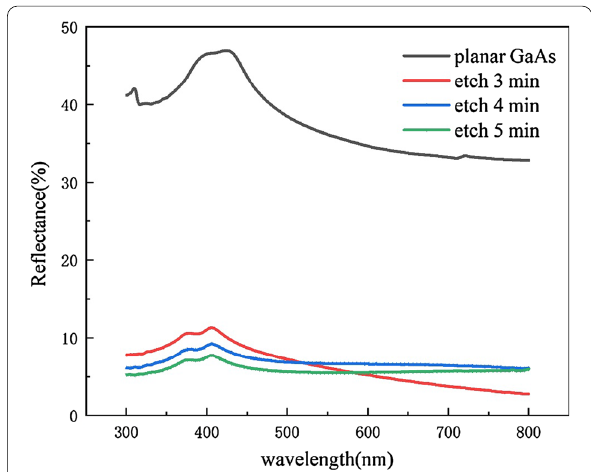
Fig. 3 Reflectance of GaAs substrate under different etching